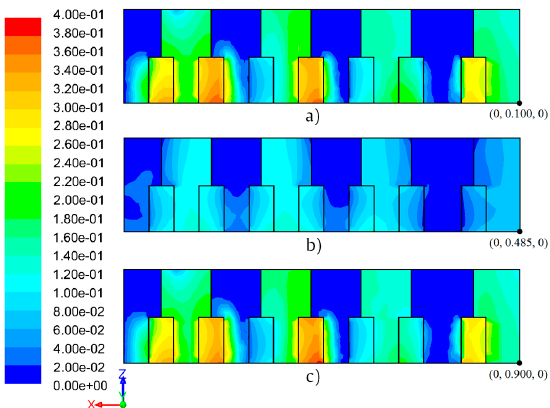
Figure 17. The results of the field of temperature in the x–z plane through the planes: ( a ) y adm = 0.100; ( b ) y adm = 0.485; and ( c ) y adm = 0.900.